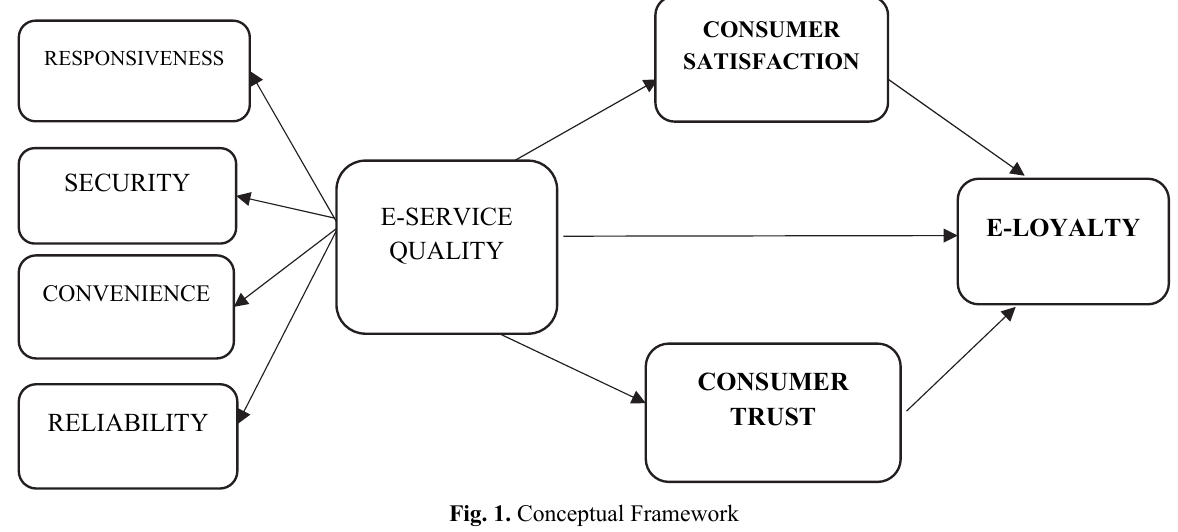
Fig. 1. Conceptual